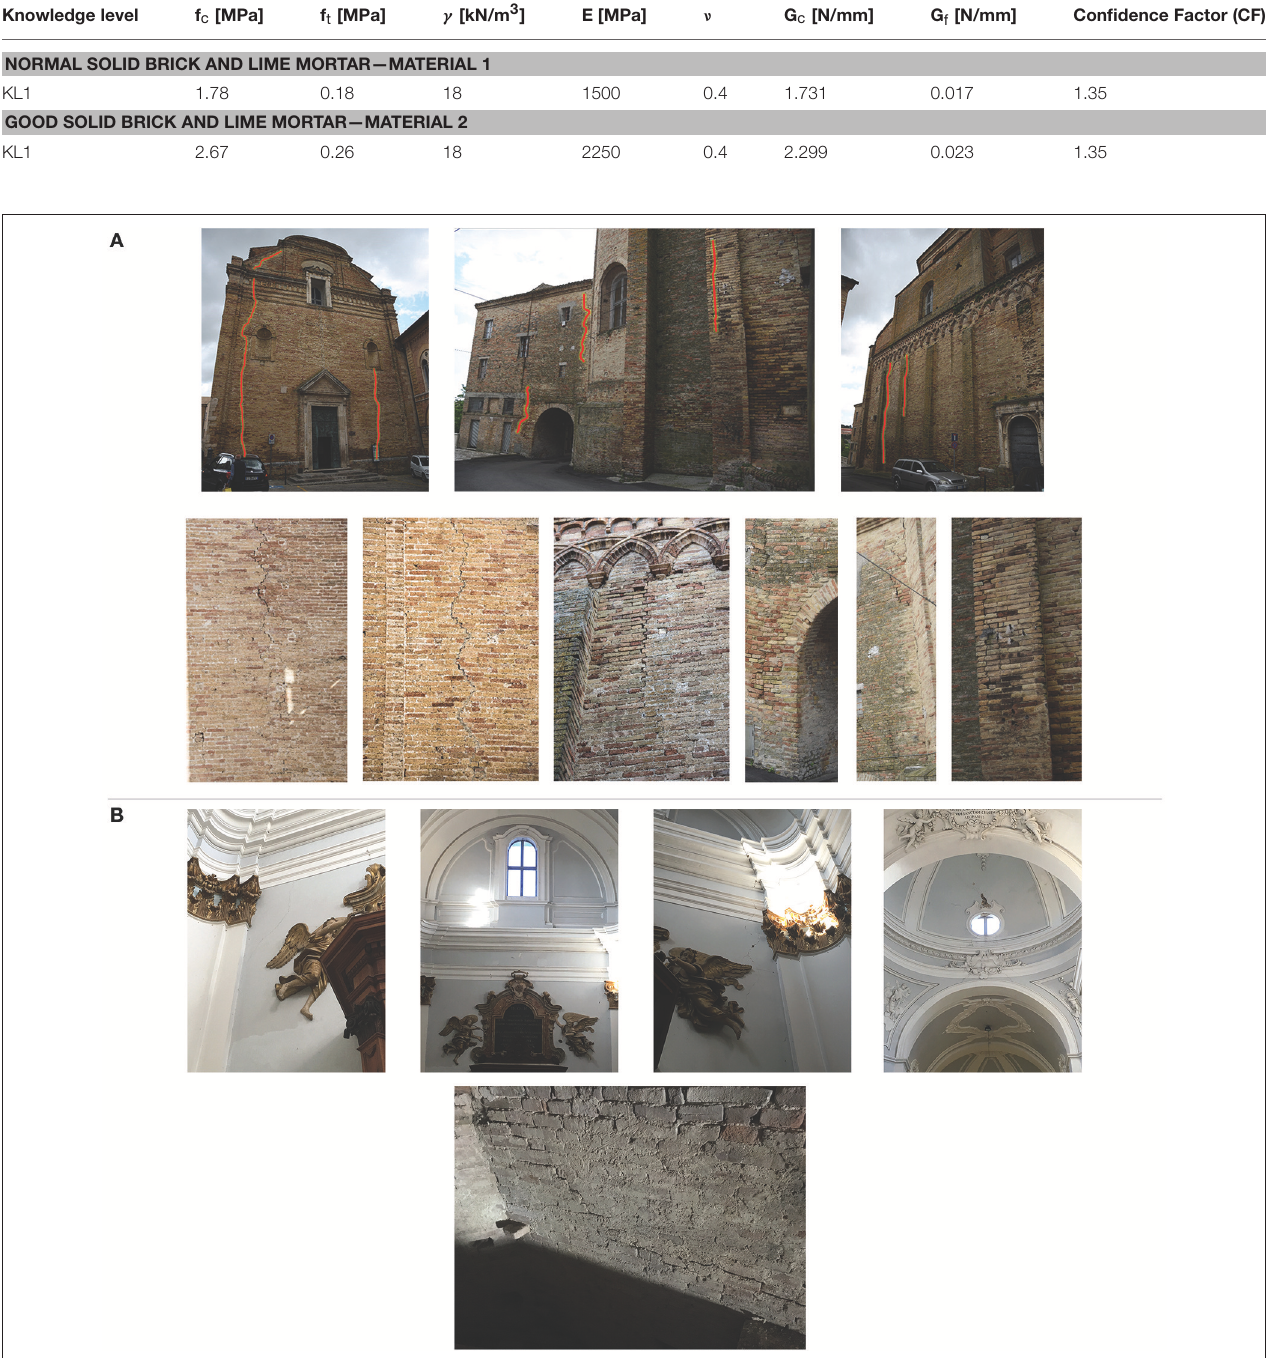
FIGURE 3 | External cracks on façade, north wall of the nave and north front of the annex (A) Internal cracks of the church (B)